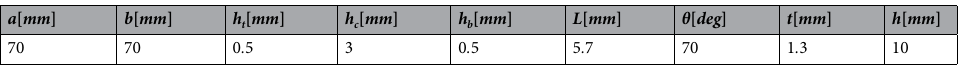
Table 1. The dimensions of the 3D printed sandwich panel prototypew with an auxetic core.